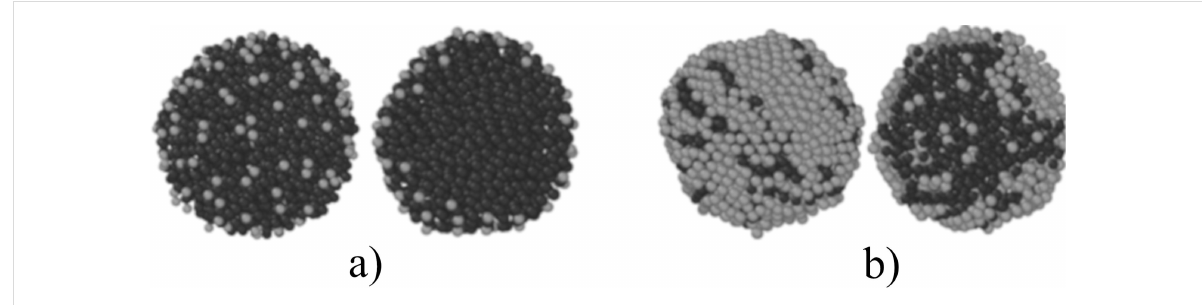
Figure 2: Clusters with different silicon contents after 1.5 ns (cooling rate 1 K/ps); dark atoms are copper, light atoms are silicon (on the left is the ap- pearance, on the right is in the incision): a) 10 atom %; b) 50 atom %.